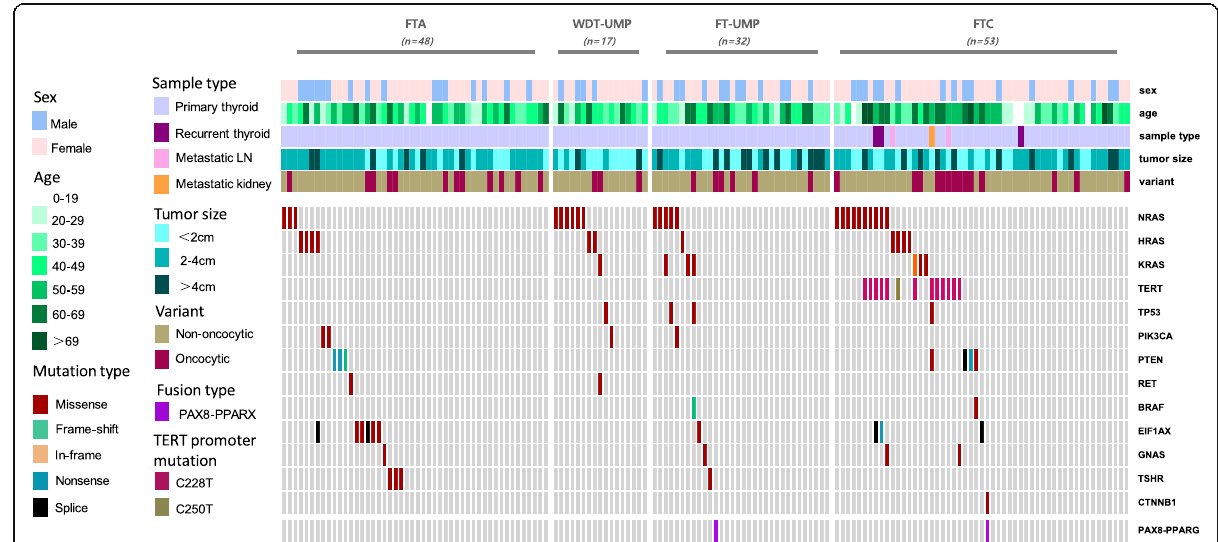
Fig. 1 Clinicopathological features and mutation spectrum in 150 follicular thyroid tumors. Clinicopathological characteristics and genes were listed on the right of the mutation spectrum and color keys for them were shown on the left